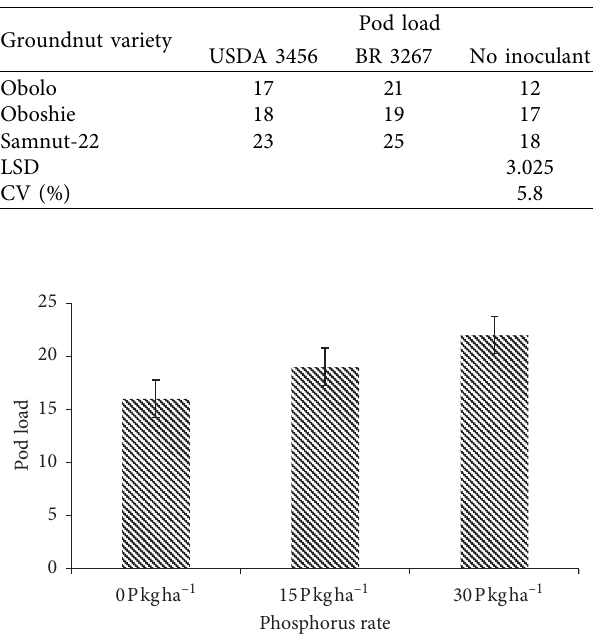
Figure 1: Effect of phosphorus on pod loads of three groundnut varieties (the bars represent LSD at P < 0 .